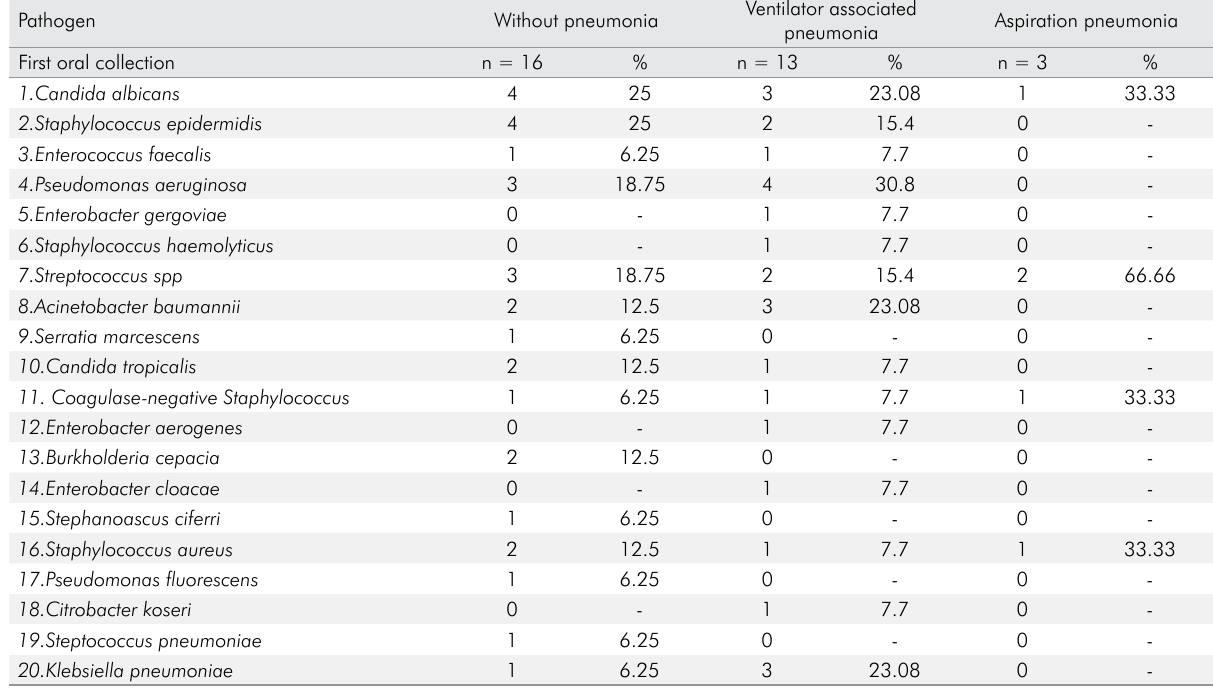
Table 2. Distribution of pathogens identified in the first (at admission) oral collection of patients on mechanical ventilation in the adult intensive care unit according to the pulmonology evolution of the patient.